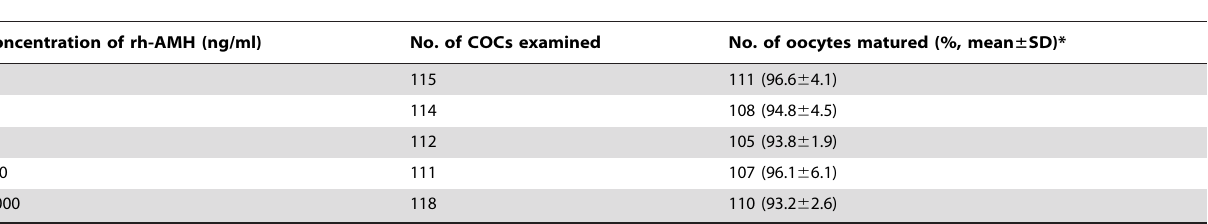
Table 2. The effect of different concentrations of rh-AMH in IVM-medium on mouse oocyte maturation following IVM.